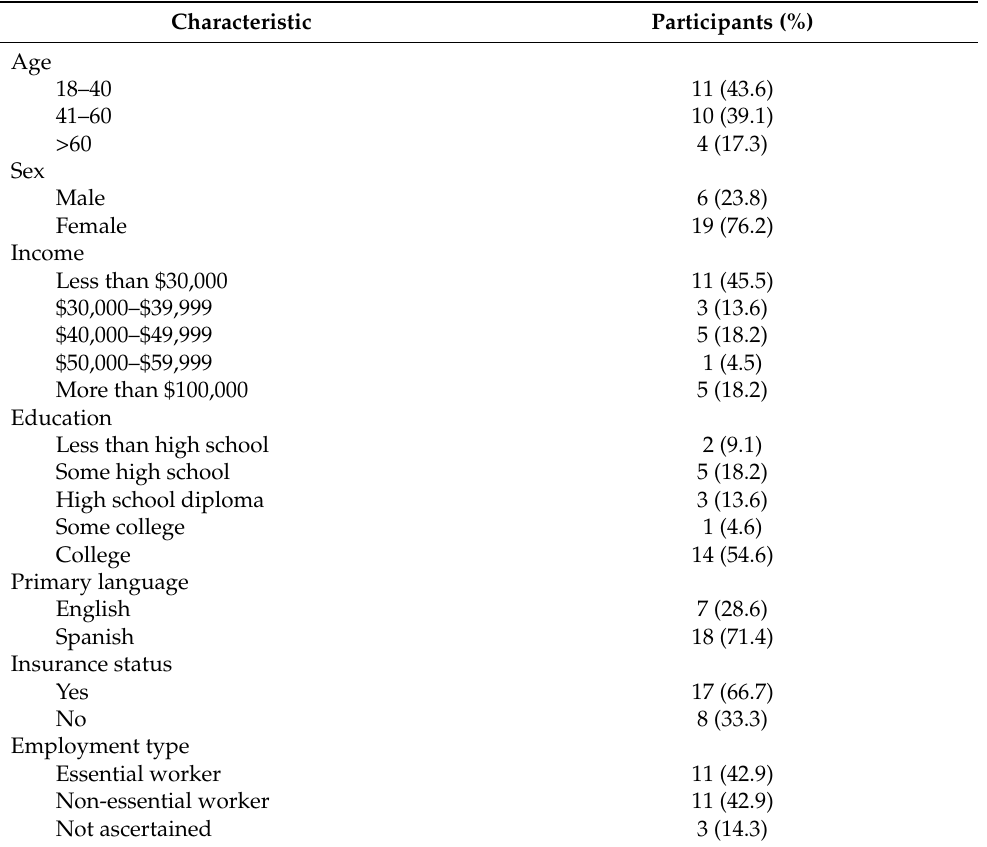
Table 1. Demographic characteristics of focus group participants ( n =